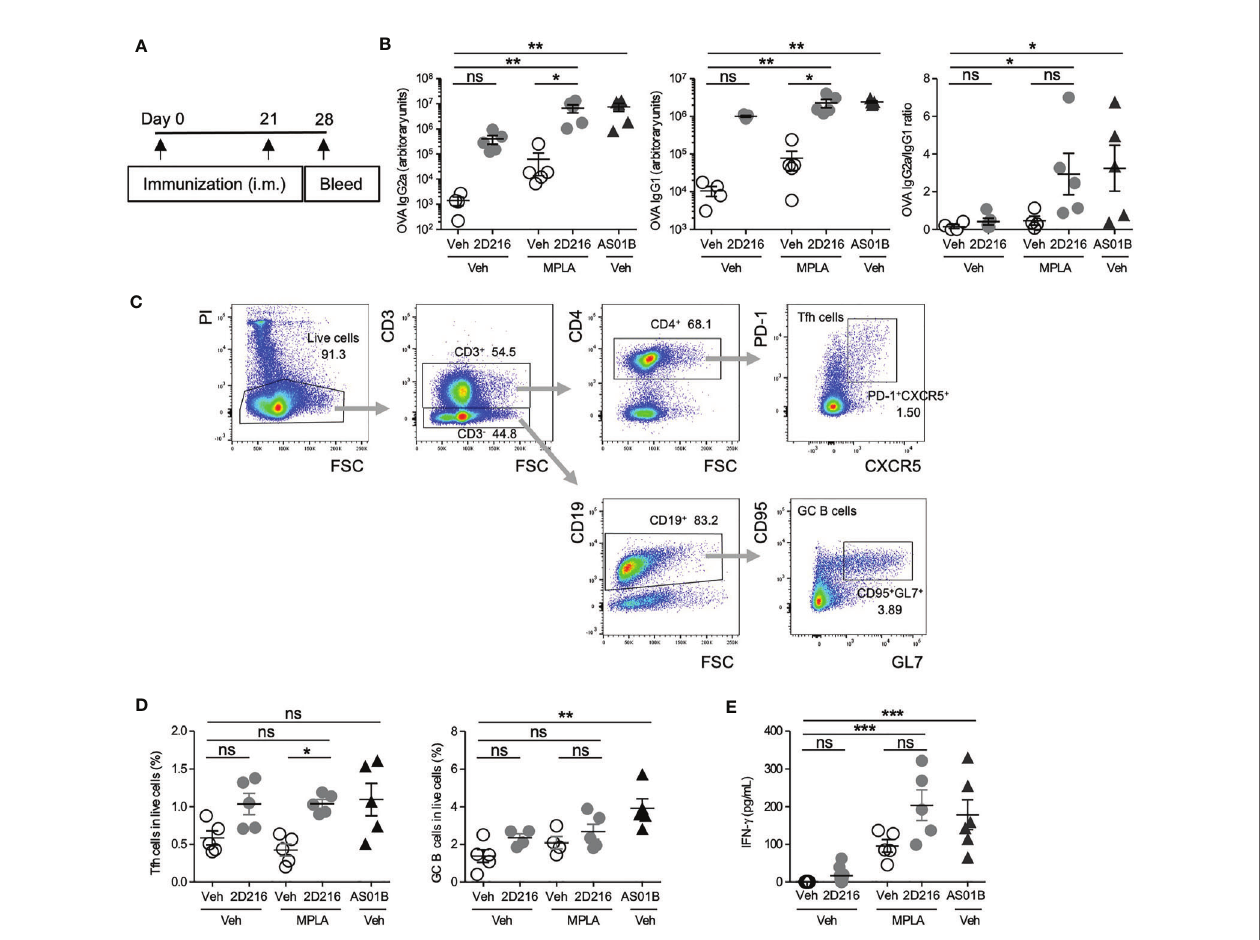
FIGURE 4 | MPLA/ 2D216 induced Th1-dominant cellular immune responses in male mice. (A) Male BALB/c mice (n = 5/group) were i.m. immunized with OVA protein (20 m g/mouse) adjuvanted with vehicle (Veh;10%DMSO in saline), 2D216 (200 nmol/mouse), MPLA (10 ng/mouse), or MPLA/ 2D216, and bled on day 28. (B) OVA-speci fi c IgG2a and IgG1 levels in sera on day 24 were assayed by ELISA. IgG2a/IgG1 ratios were calculated. (C, D) On day 28, draining lymph nodes were harvested, and Tfh and GC B cells were examined by fl ow cytometry analysis. The gating strategy is shown (C) . Percent Tfh cells (CD3 + CD4 + PD-1 + CXCR5 + ) and GC B cells (CD3 - CD19 + CD95 + GL7 + ) in the gated live cells are shown (D) . (E) On day 28, splenocytes (5×10 6 cells/mL) were harvested and re-stimulated with OVA (100 m g/mL) for 3 days. The levels of IFN- g in the culture supernatants were measured by ELISA. Data shown are means ± SEM of two independent experiments showing similar results. *p < 0.05, **p < 0.01, ***p < 0.001 by Kruskal-Wallis tests with Dunn ’ s post hoc test. ns, not signi fi